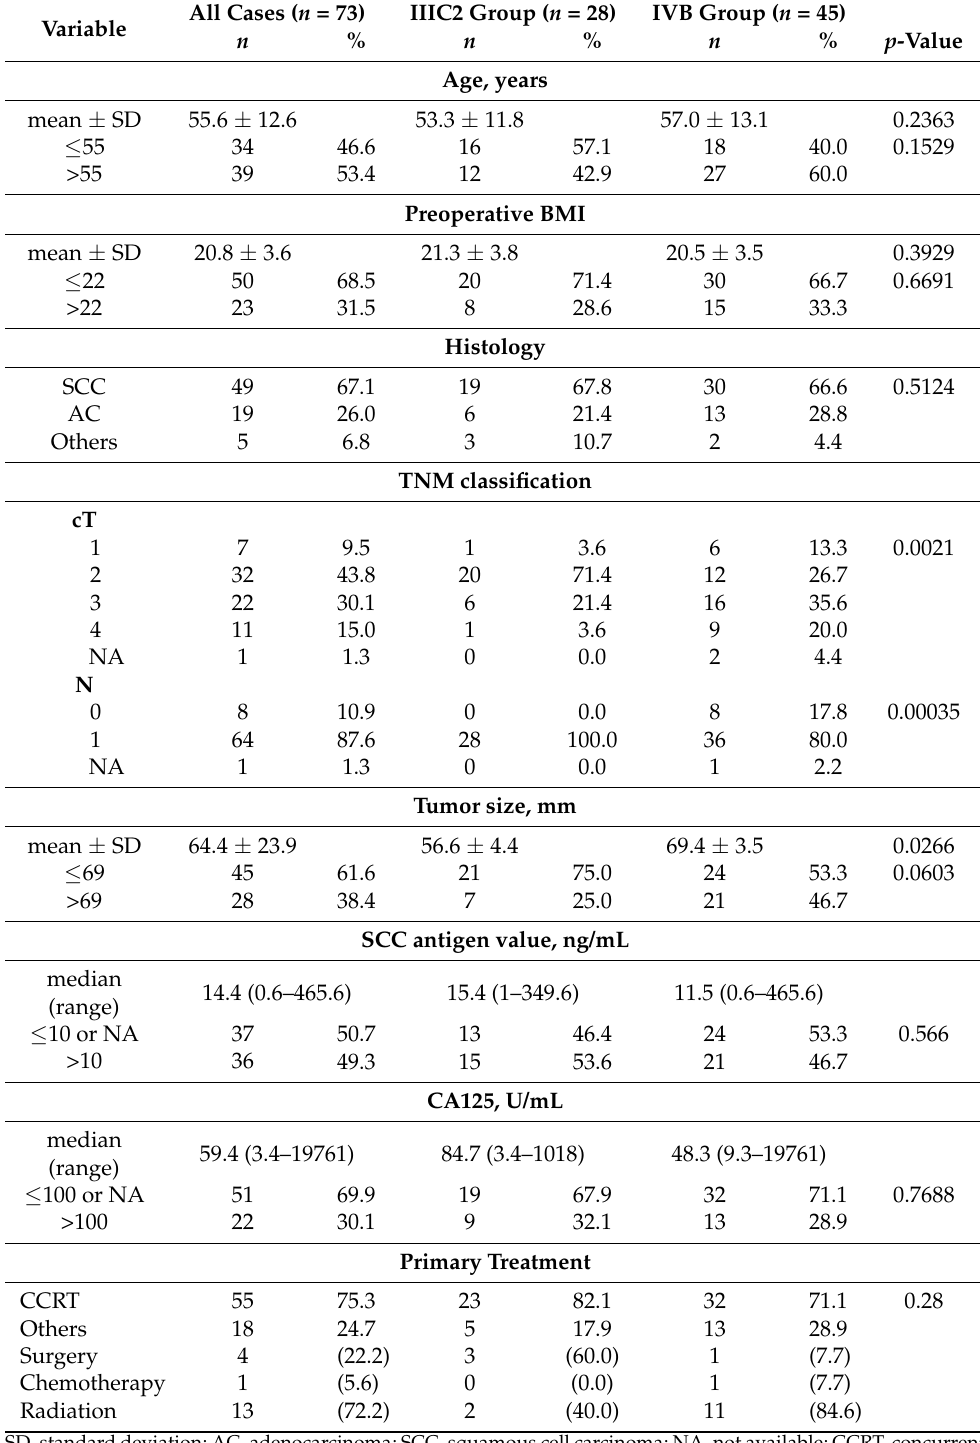
Table 1. Patients’ clinical characteristics stratified by the IIIC2 and IVB